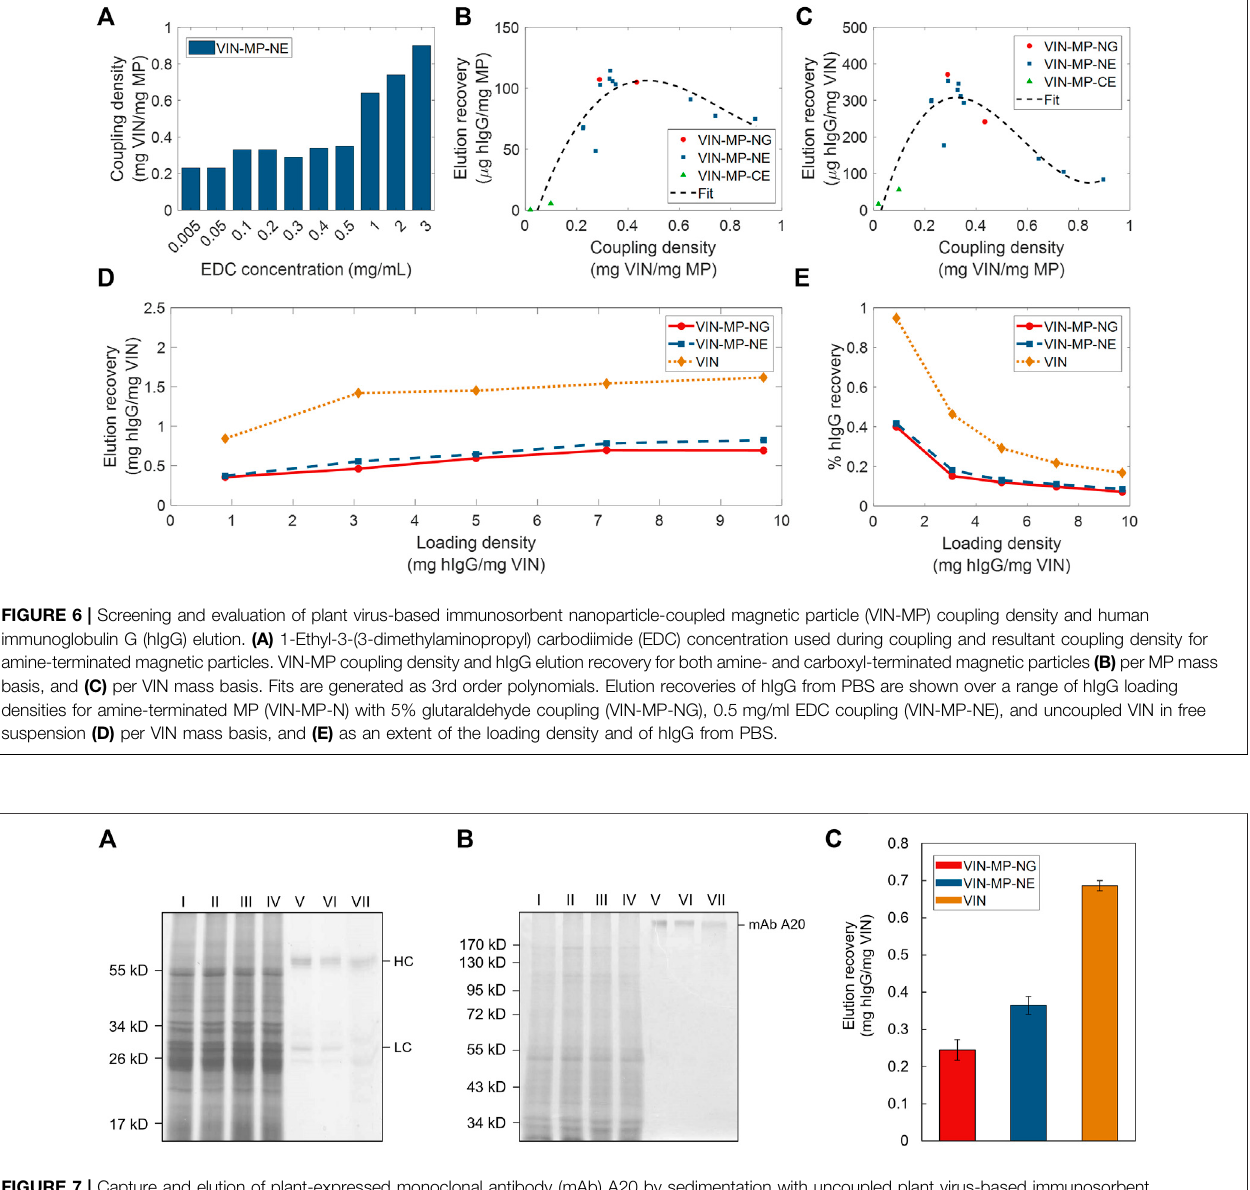
FIGURE 7 | Capture and elution of plant-expressed monoclonal antibody (mAb) A20 by sedimentation with uncoupled plant virus-based immunosorbent nanoparticle (VIN) and magnetic separation with VIN-coupled magnetic particle (VIN-MP). (A) Reducing and, (B) non-reducing SDS-PAGE results of the non-bound supernatantandelutionrecoveryofplant-expressedmAbA20forVIN-MPwith5%glutaraldehydecoupling(VIN-MP-NG),0.5 mg/ml1-Ethyl-3-(3-dimethylaminopropyl) carbodiimide coupling (VIN-MP-NE), and uncoupled VIN in free suspension. Gels are marked with band heights corresponding to mAb A20 heavy chain (HC) and light chain (LC) constituents (reduced) or to dimerized mAb A20 (non-reduced). (C) Elution recovery of plant-expressed mAb A20 from crude plant extracts by VIN capture normalized to the initial mass of VIN for VIN-MP-NG, VIN-MP-NE, and uncoupled VIN in free suspension. Error bars represent a single standard deviation of technical triplicate